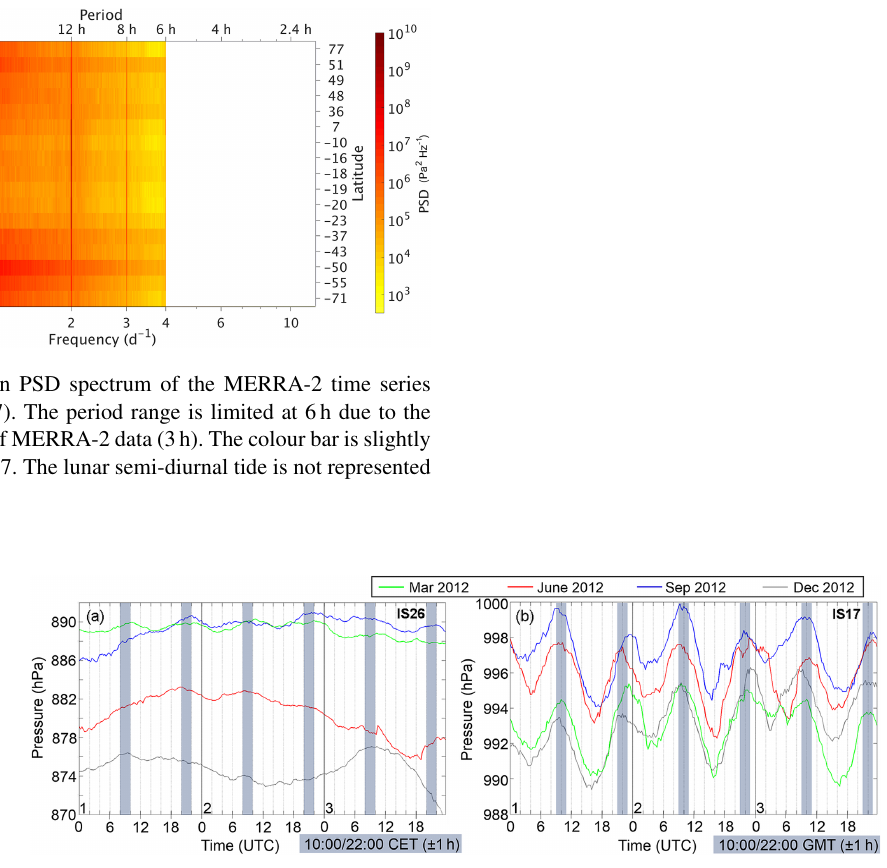
Figure A3. Absolute pressure on three days of different seasons at (a) IS26 (UTC + 01) and (b) IS17 (UTC + 00). The semi-diurnal tide can clearly be detected by the naked eye at the tropical station IS17, whereas at IS26 synoptic pressure variations mask the reduced tidal effect in the mid-latitudes. The grey columns indicate the expected times of the semi-diurnal tides’ pressure maxima (e.g. Haurwitz, 1956). Note that these barometric recordings are exemplarily shown for 2012 and are not necessarily representative for any of the four